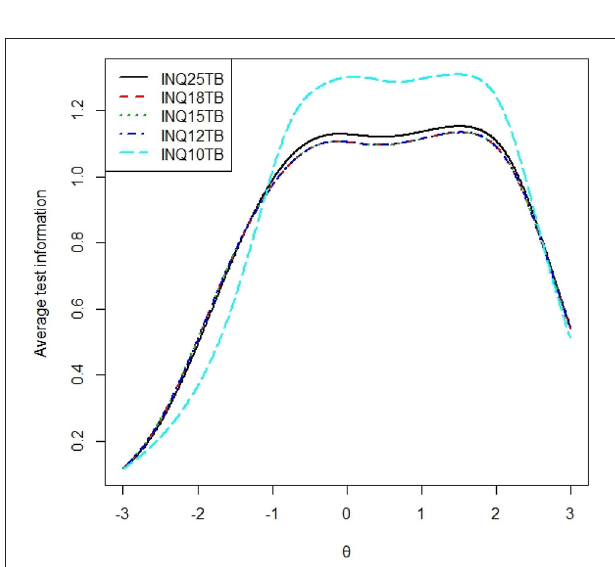
FIGURE 4 | Average test information curves of thwarted belongingness of each